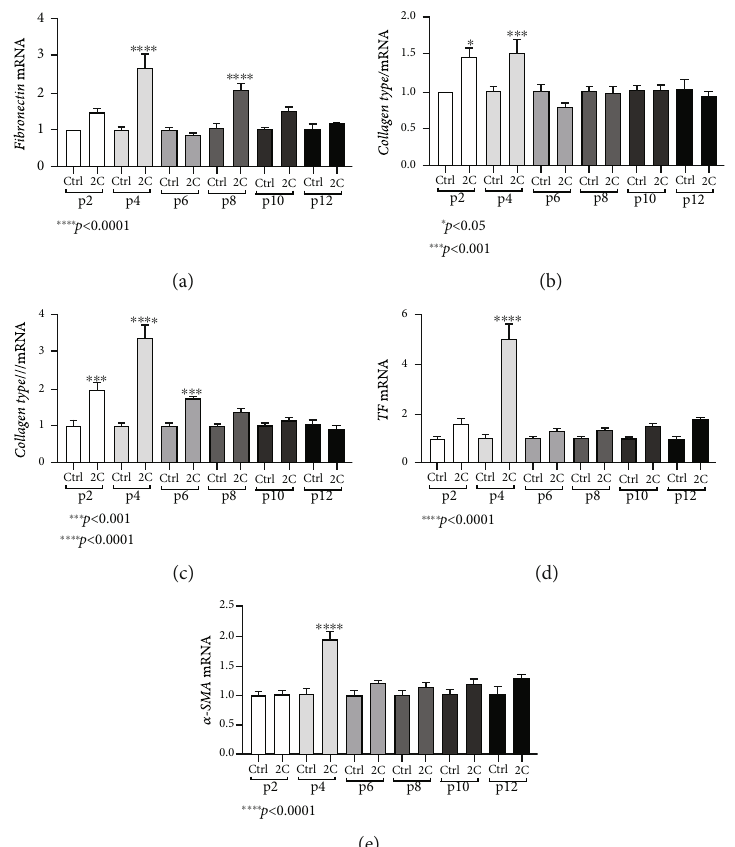
Figure 4: HIOs exhibit fi brotic responses to in fl ammatory cytokines. IL-1 α and TNF- α (2C) induced the mRNA expression of α -SMA in passage 4 (a), fi bronectin in passages 4 and 8 (b), TF in passage 4 (c), collagen type I in passages 2 and 4 (d), and collagen type III in passages 2, 4, and 6 (e). Concentrations of cytokines used: IL-1 α 5 ng/ml, TNF- α 50 ng/ml. All experiments were performed in triplicate. The gene expression of each studied gene was normalized against GAPDH gene expression in the same sample using the 2 - ΔΔ Ct method. In every passage, expression levels of treated organoids were normalized against those of the control ones. Data are presented as the mean ± standard errorof themean ð SEM Þ